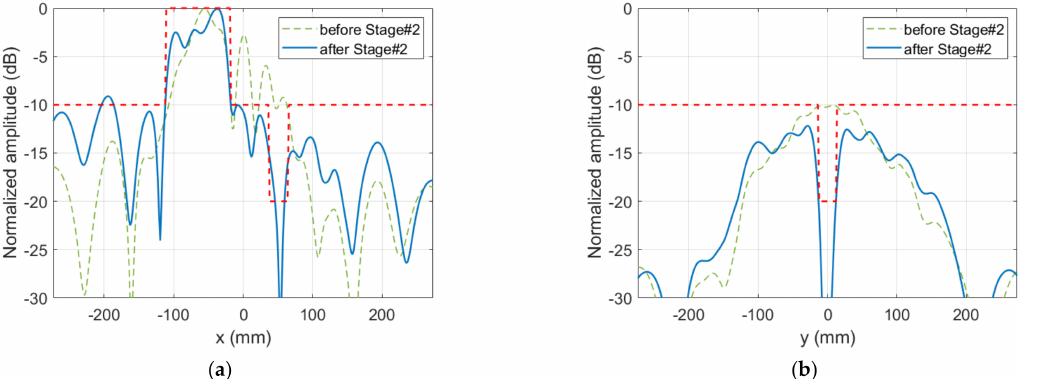
Figure 8. Case 1, Stage#2: main cuts of the synthesized near field and comparison with templates. ( a ) cut y = 0; ( b ) cut x = 51.9